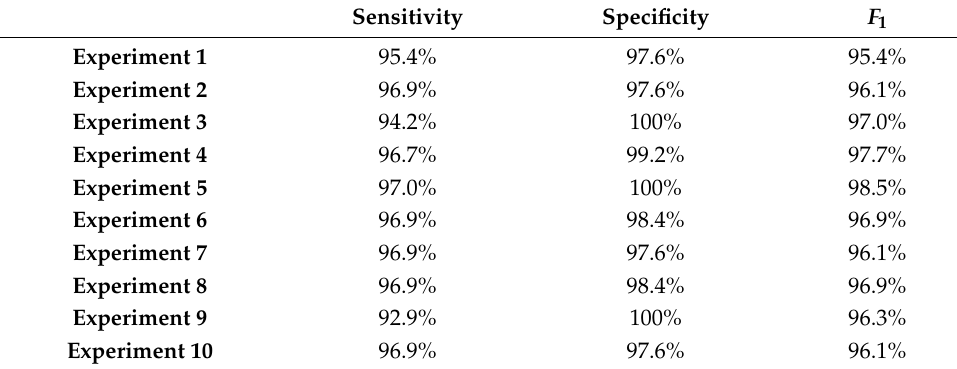
Table 3. Performance obtained across the 10 experiments for the Xception-based CNN. Sensitivity Specificity F 1 Experiment